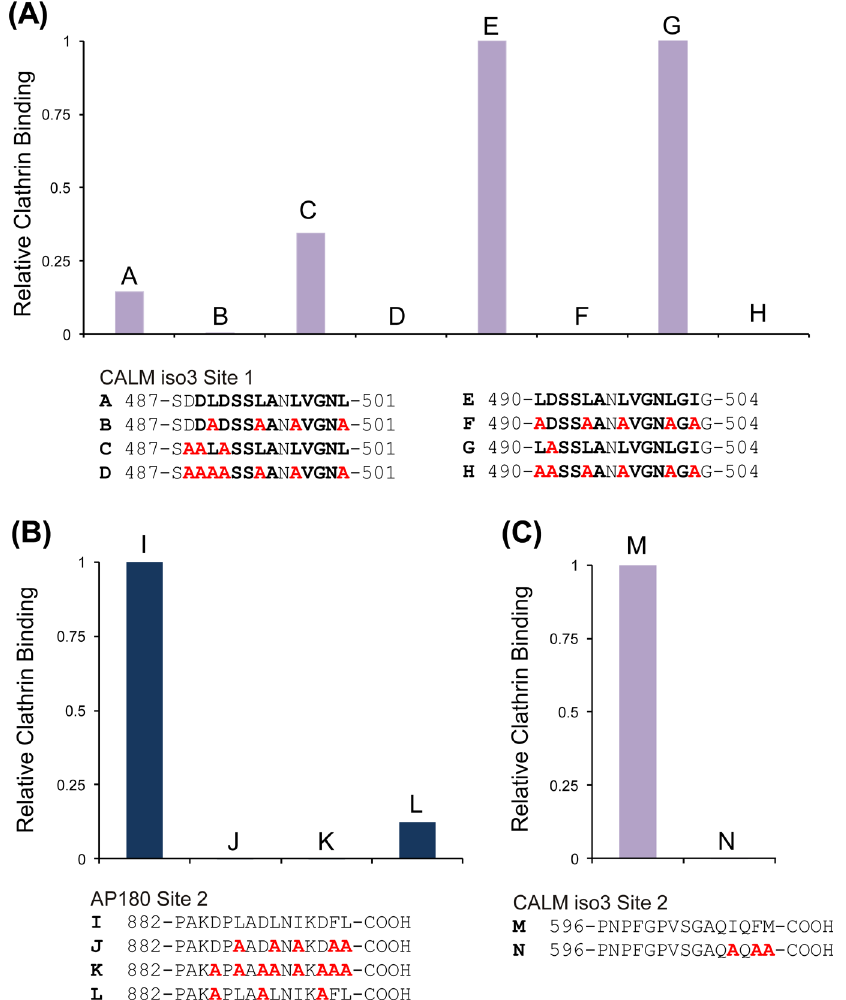
Fig 2. Substitution of amino acid residues in peptides from Site 1 and Site 2 to identify those important for clathrin binding. Hydrophobic amino acids (Leu, Ile, Met, and Phe), Asp residues and conserved residues in the extreme C-terminus were substituted with Ala (red residues) in peptide array overlay assays with purified clathrin. Bold residues indicate conserved amino acids. (A) CALM Site 1 substitutions and their effect on clathrin binding to 15mers ( n = 1). The intensity for each 15mer has been divided by the intensity of clathrin binding to 15mer E (B) AP180 Site 2 substitutions and their effect on clathrin binding to 15mers ( n = 1). The intensity for each 15mer has been divided by the intensity of clathrin binding to 15mer I (C) CALM Site 2 substitutions and their effect on clathrin binding to 15mers ( n = 1). The intensity for each 15mer was divided by the intensity of clathrin binding to 15mer